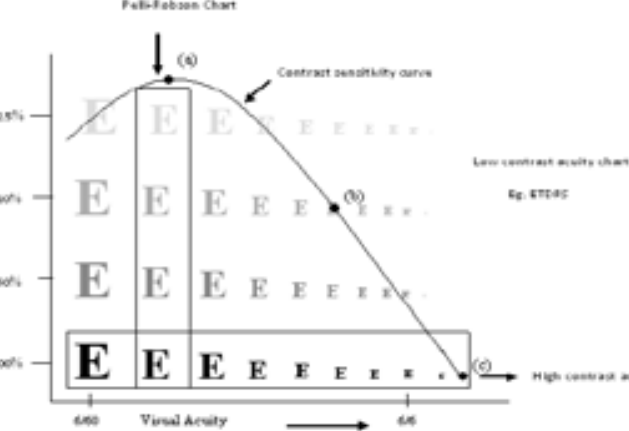
Figure 7. Contrast level (in percentage) is plotted on the vertical or y -axis against contrast visual acuity (CVA) on the horizontal axis. Only a single optotype, namely the letter “E” is shown on the graph. On the left side of the graph, 6/60 letters diminish in contrast from 100 to 25% (where the letter “E” becomes paler) whereas visual acuity diminishes in size along the horizontal or x -axis where the size of the letter decreases from 6/60 to 6/6. The boundary between seen and unseen letters is depicted by the curve, known as the contrast sensitivity curve (CSC). The declining right-hand slope of the CSC is measured mainly with medium and low contrast visual acuity charts which may indicate neuro-ophthalmological abnormalities in the early stage of disease such as diabetes mellitus and glaucoma. (Figure has been adapted from Norton, Corliss and Bailey 1